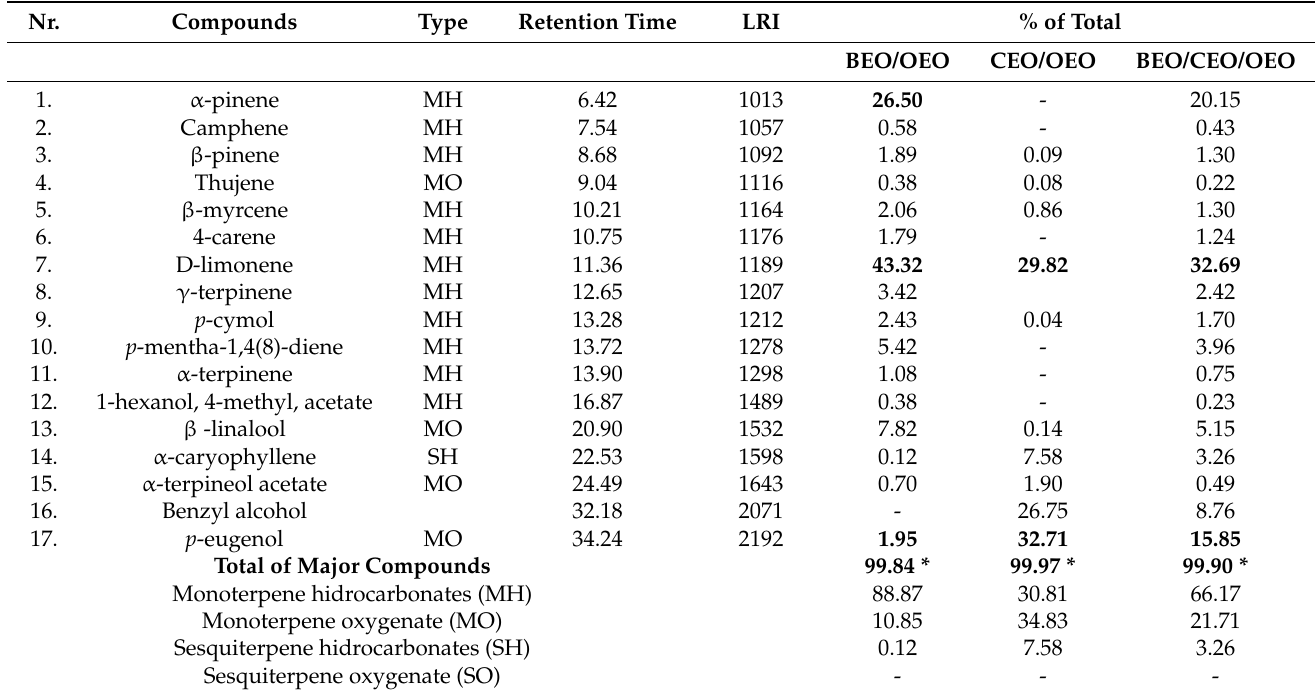
Table 1. Chemical composition (% of total) of EOs binary (BEO/OEO), (CEO/OEO) and ternary mixtures